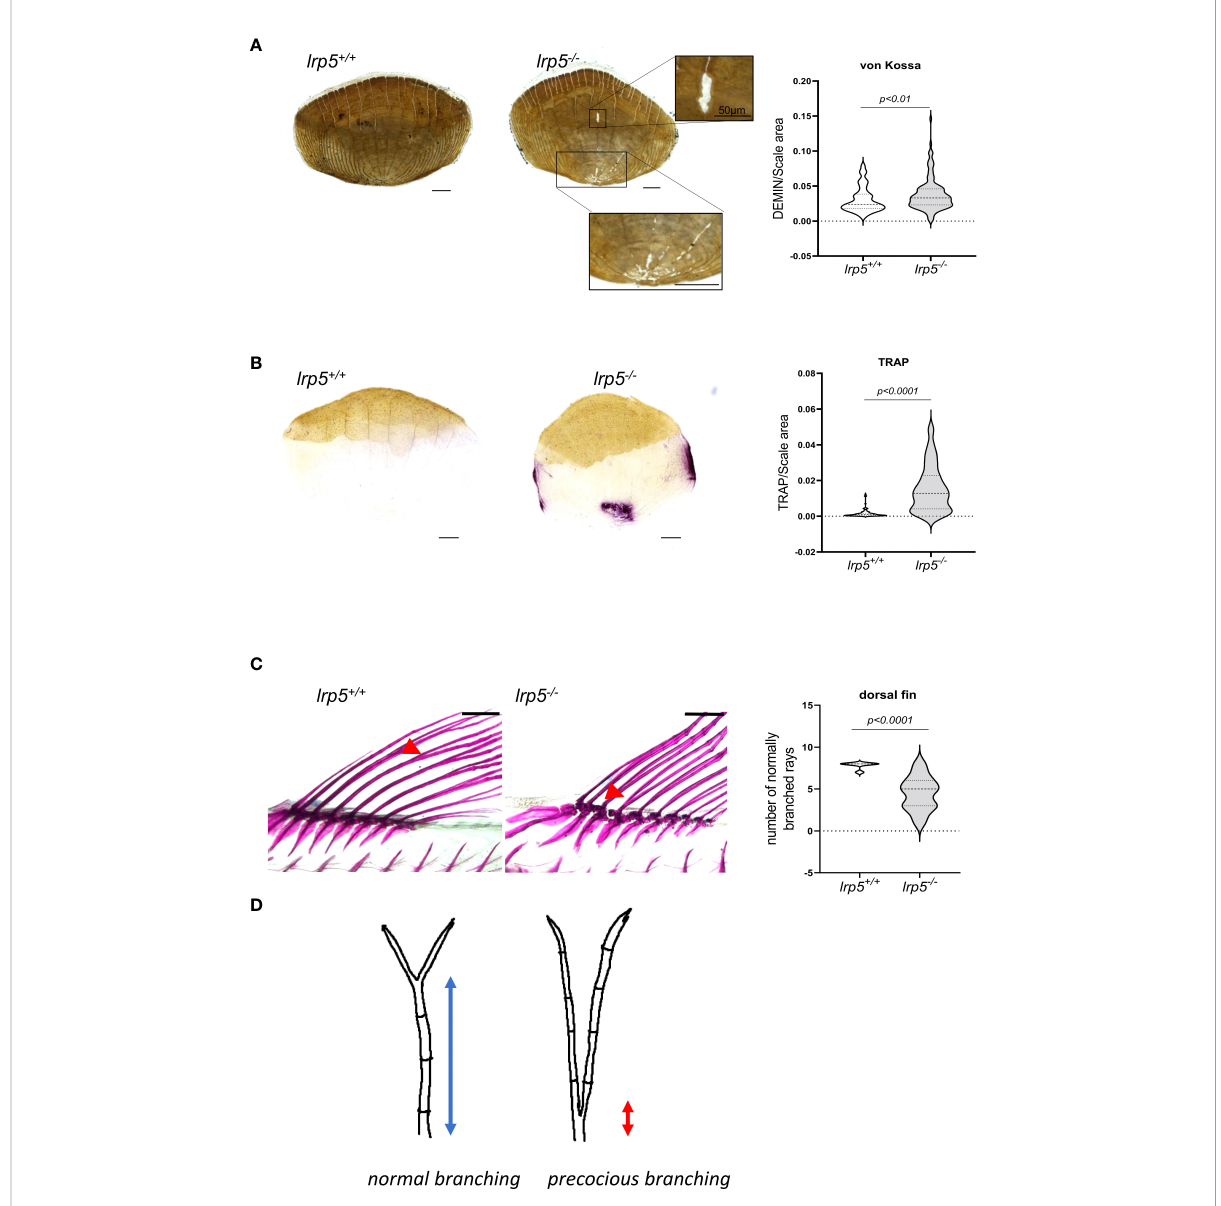
FIGURE 6 lrp5 -/- scales display a larger demineralized area and TRAP positive area. (A) von Kossa staining of lrp5 -/- scales revealed signi fi cantly more demineralized area (t-test, n of scales per group=120-130) than of control siblings scales. (B) TRAP staining of lrp5 -/- scales indicates signi fi cantly larger TRAP area compared to lrp5 +/+ (t-test, n of scales=95-101). Scale bar=100µm. (C) Branching of lepidotrichia in lrp5 +/+ fi ns occurs in distal segments (red arrows), meanwhile lrp5 -/- fi sh display bifurcation in proximal segments of lepidotrichia (C, red arrows). The number of normally branched fi n rays is signi fi cantly lower in lrp5 -/- compared to lrp5 +/+ siblings. (D) Schematic representation of excessive branching in lrp5 -/- . Results in A, B and C are expressed as mean